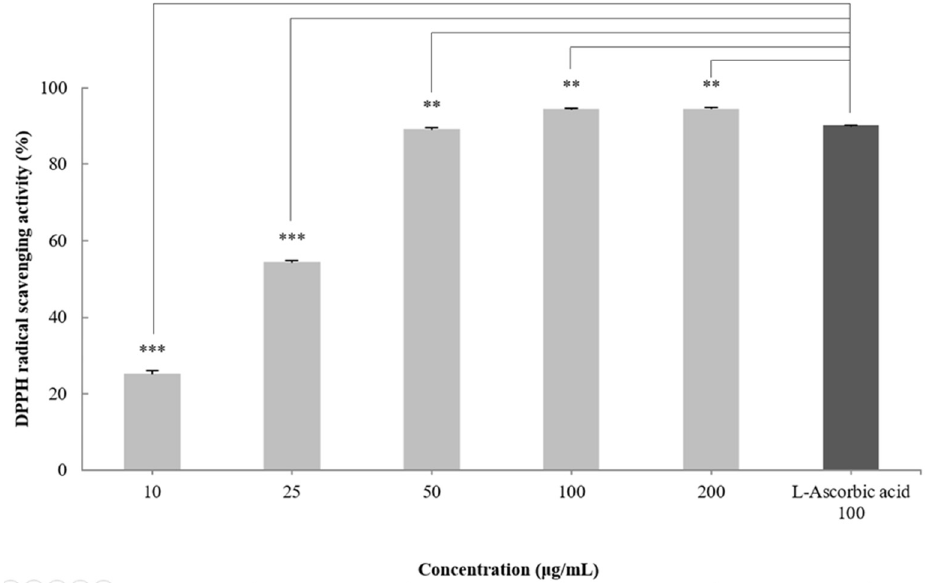
Figure 1. DPPH radical scavenging activity of CGCS extracts. The results are expressed as the mean ± SD from three independent experiments. ** p < 0.01, *** p < 0.001 compared with the control.